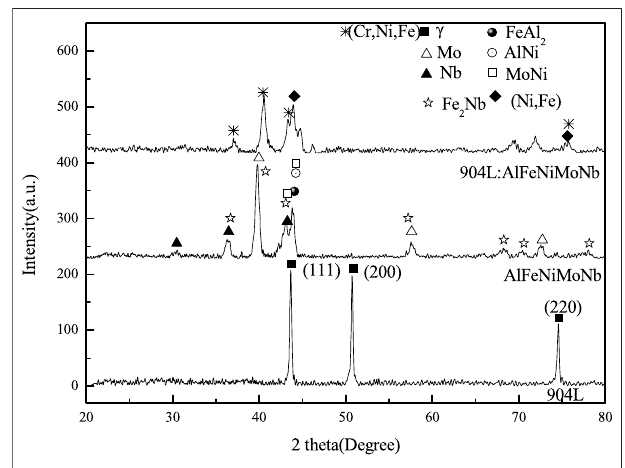
FIGURE 3 | X-ray diffraction patterns of the obtained alloys before corrosion